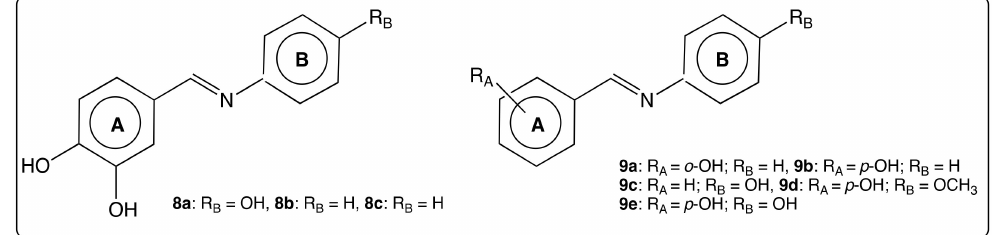
Figure 11. Structure of AZA-ST 8a – c and 9a – e [64].